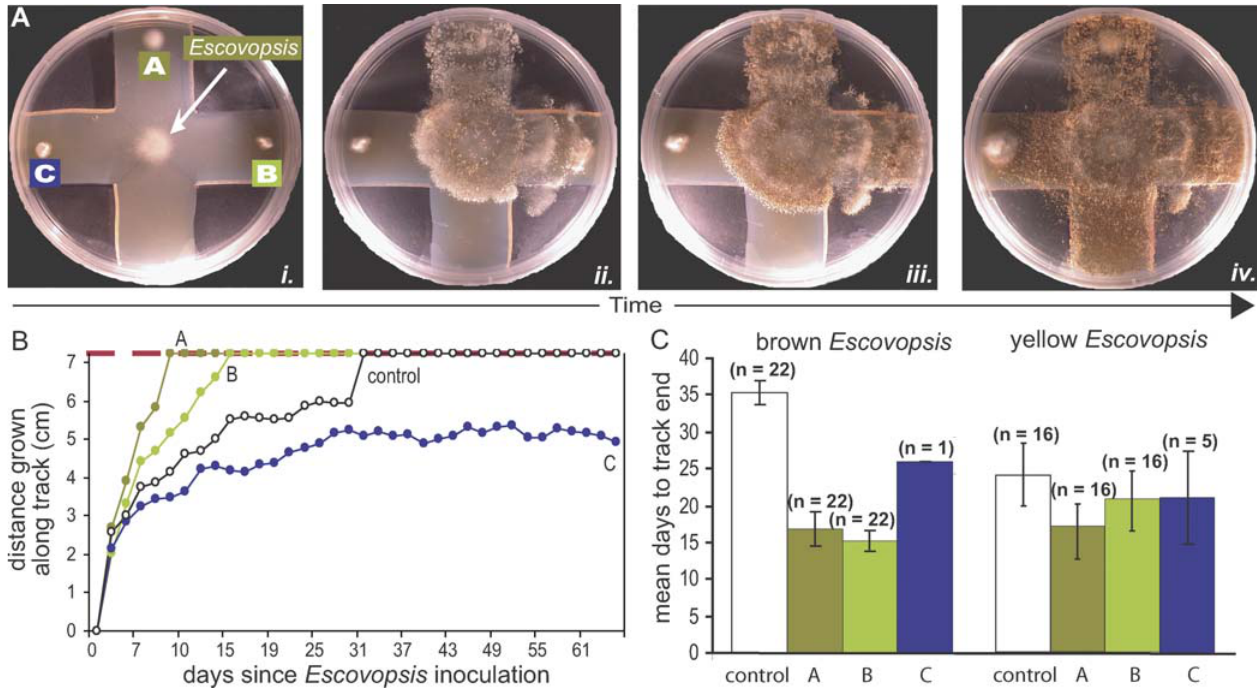
Figure 2. Fungal-Choice Bioassays (A) Isolates of cultivars A, B, and C are placed at the end of each of three tracks, and one track remains blank as a control. Brown Escovopsis begins to grow concentrically (i), but over time overgrows cultivar A (ii), then cultivar B (iii), then the end of the control track (iv) . After several months, the parasite has still not overcome the zone of inhibition surrounding cultivar C (iv). (B) Progression of Escovopsis growth over time on the plate shown in (A); the red, dashed line indicates the track end, at which the pathogen overgrows the cultivar. (C) Average number of days to reach each cultivar type in fungal-choice bioassays. For cultivar C, results are included only for trials in which Escovopsis was able to overgrow cultivar C and reach the end of the track. DOI: